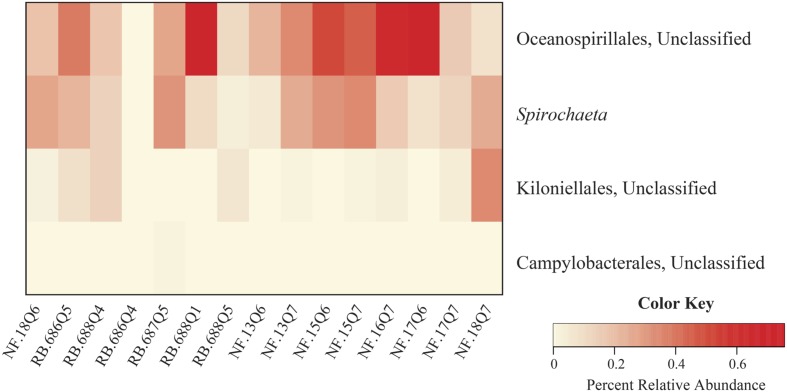
Core microbiome of Anthothela samples. A heatmap was created to visualize the core community of the 15 samples within the Anthothela genus. Bacterial taxa represented in this figure were unique to the Anthothela spp. core microbiome present in 90% of the samples.